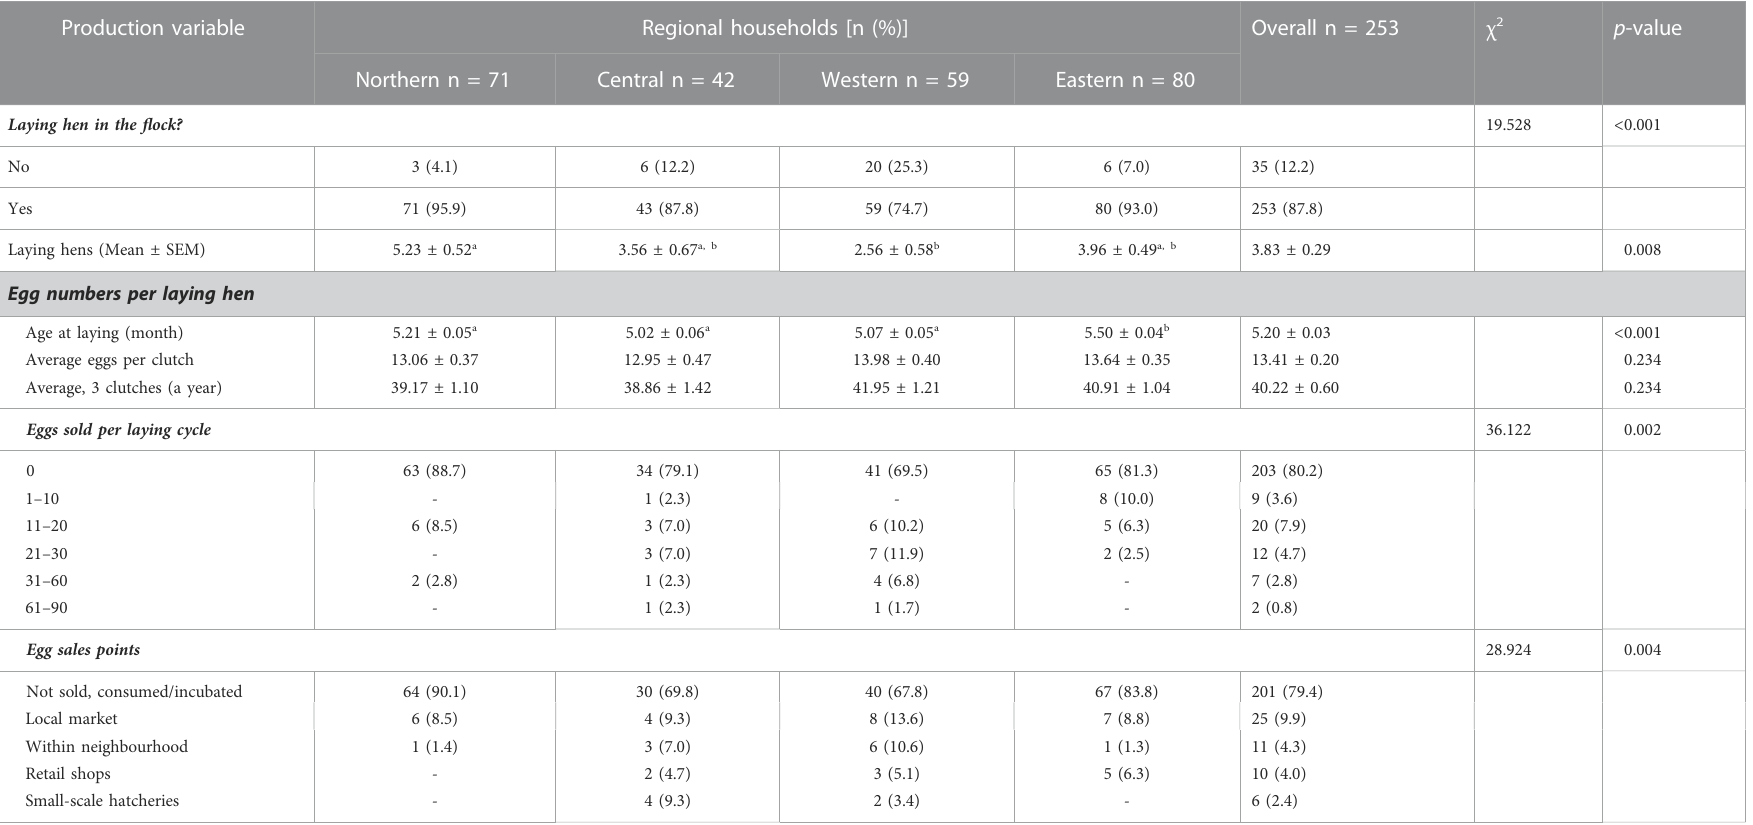
TABLE 5 Egg production and sale of indigenous chickens in